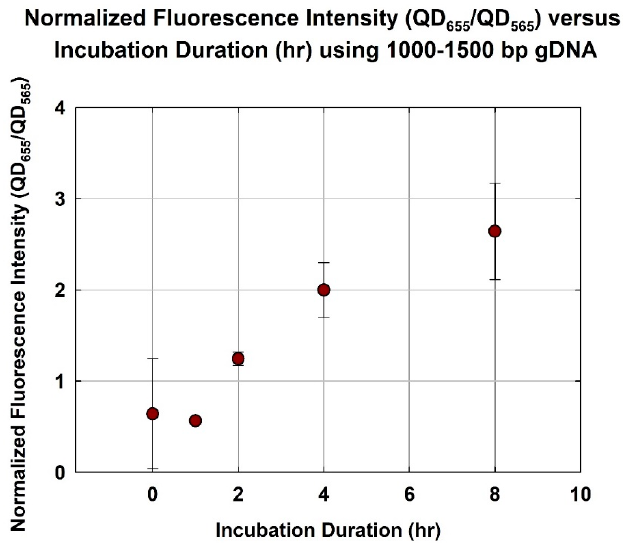
Figure 4. Normalized fluorescence intensity (QD 655 /QD 565 ) versus incubation duration (h) using optimum size range gDNA (1000–1500 bp).